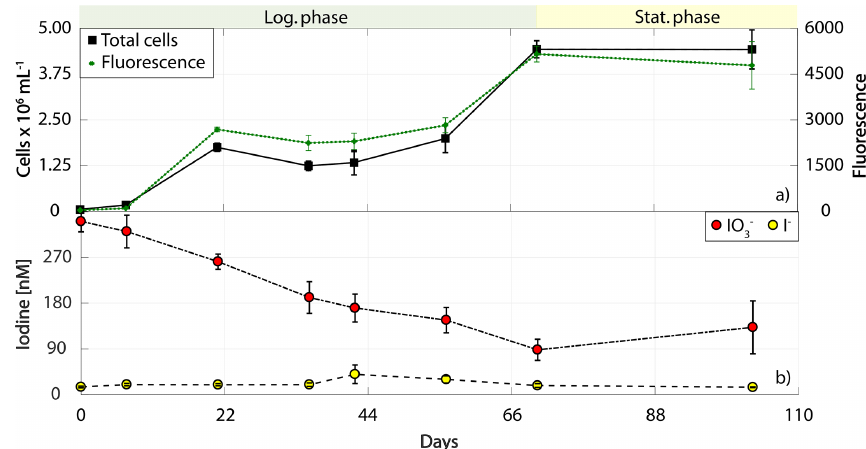
Figure 5. Total cell counts (black – total) and fluorescence readings (green) as well as inorganic iodine speciation (red – iodate, yellow – iodide) over the course of the growth curve experiments of Synechococcus sp. (RCC 2366). The colour-shaded bars on top of each graph indicate where the logarithmic phase (green) and the stationary phase (yellow) started and ended based on total cell counts. Values depicted are means from culture replicates, with error bars indicating the standard deviations of these means.